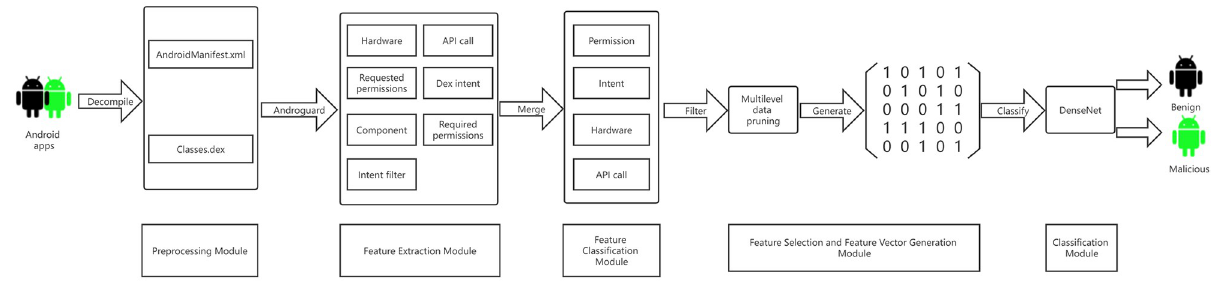
Fig 4. The system architecture of the proposed approach.